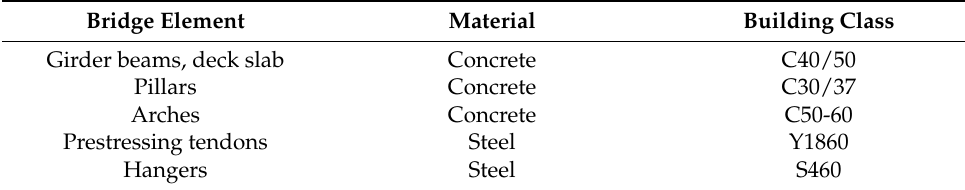
on the abutments) through 3250 kN (at axes 3 and 4) to 3600 kN (at axes 2 and 5). The pillars are 5.9 m high and have square cross-sections of 1.4 × 1.4 m.